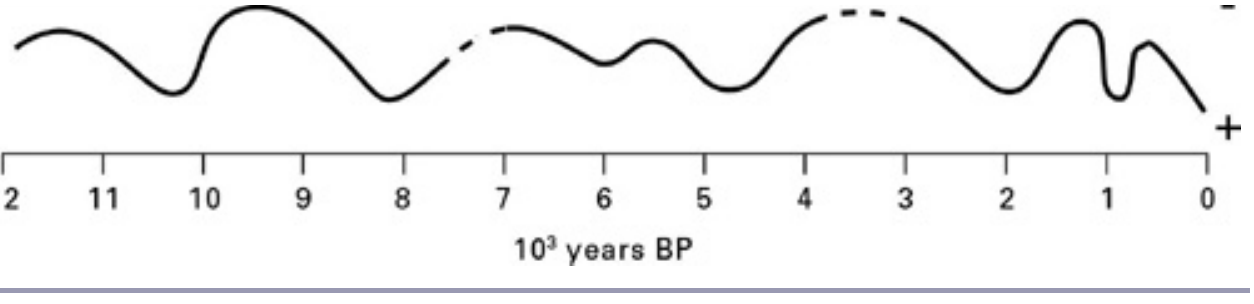
Fig. 5. Variations in fluvial activity in the upper Vistula River basin, Poland, through the Holocene. Phases of increased (+) and decreased (-) fluvial activity have been identified through interpretation and dating of alluvial fills and abandoned palaeochannels. Phases of higher fluvial activity correlate with braided channel patterns, whereas stable phases correlate with meandering channel pattterns (Redrawn from Starkel 1991 a ).